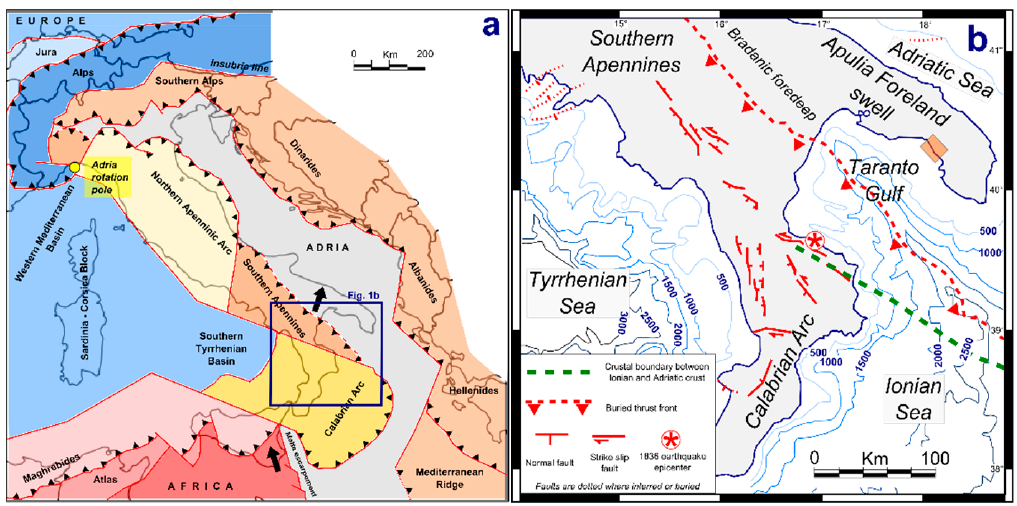
Figure 1. a (left): Geodynamic sketch of the Adria plate and surrounding areas (from [5]; mod.). Black arrows indicate plate motion; the blue box marks the area mapped in Figure 1b. b (right): Regional tectonic setting of Southern Italy (from [6]; mod.); the main active faults on land and offshore and the 1836 Rossano earthquake epicenter are shown. The orange box indicates the position of the studied coastal